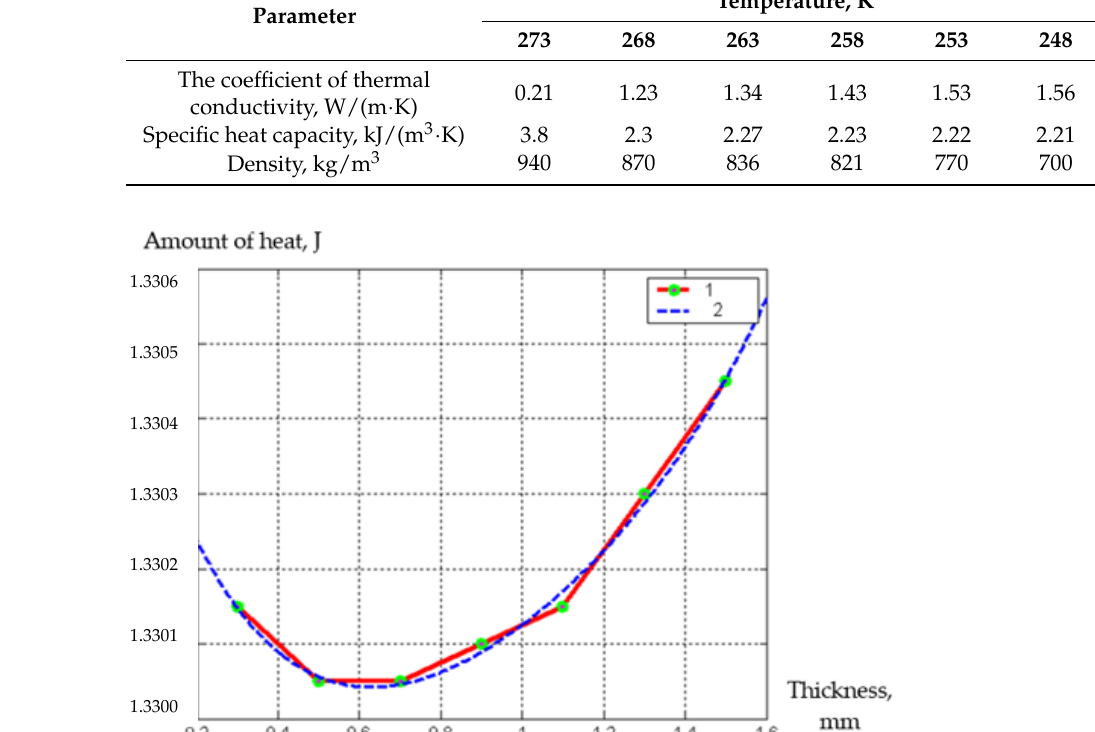
Table 2. Distribution of thermophysical parameters versus temperature. The coefficient of thermal conductivity, W/(m·K) 0.21 Temperature, K Parameter